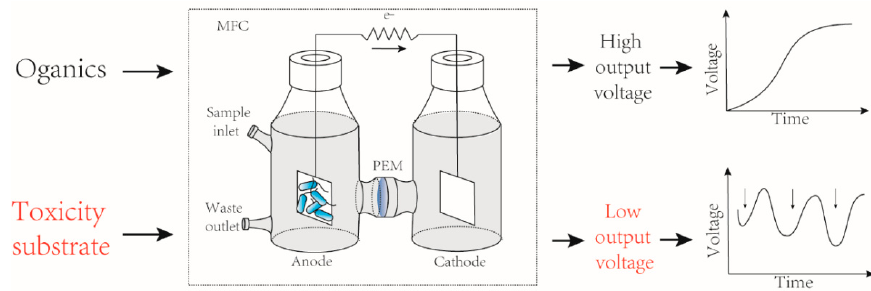
Figure 5. A typical dual-chamber microbial fuel cell used as a toxicity biosensor.